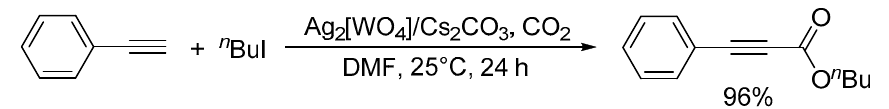
Scheme 5. Carboxylation of phenylacetylene with n -butyl iodide catalyzed by Ag 2 [WO 4 ]/Cs 2 CO 3 .